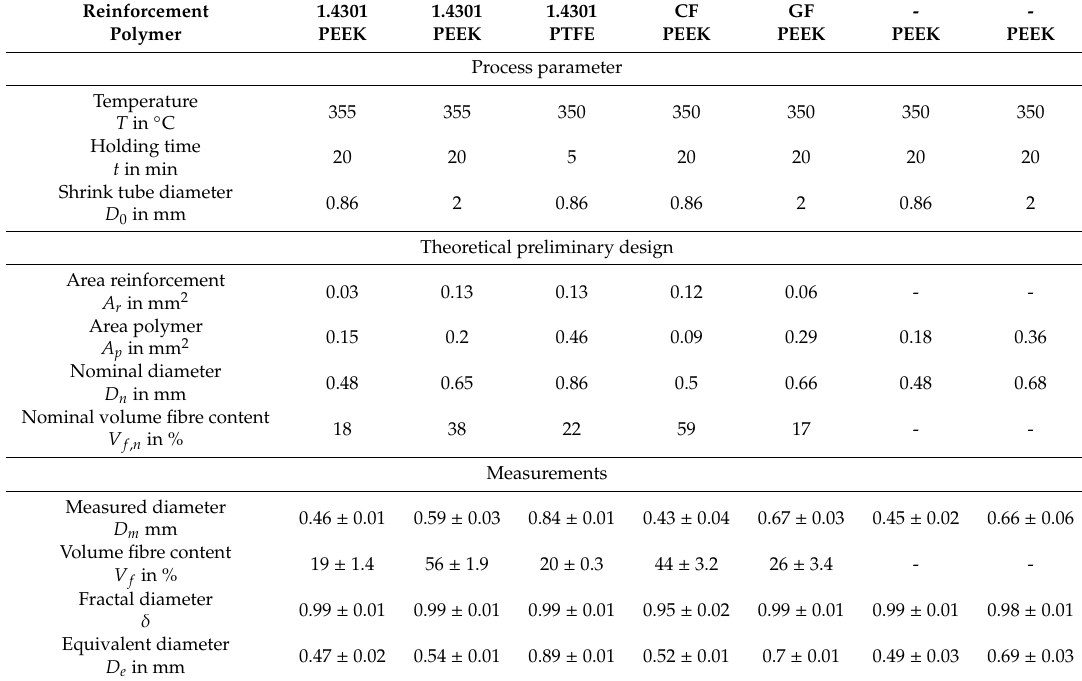
Table 2. Parameters of shrink tube consolidation and resulting semi-finished product’s dimensions (mean ± standard